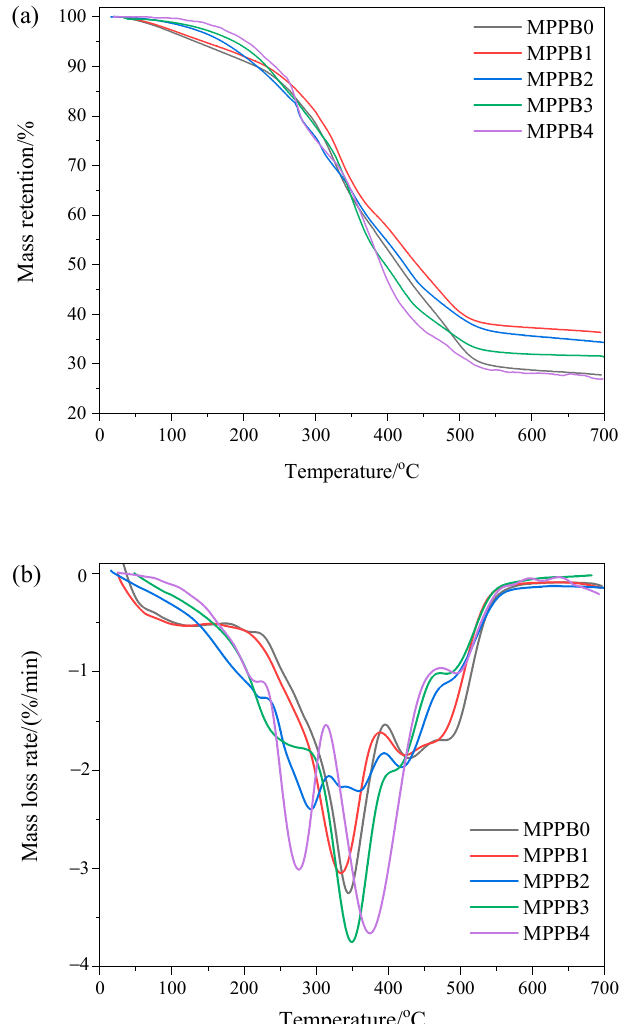
Table 3. Thermal parameters of the MPPBs coatings under nitrogen atmosphere.